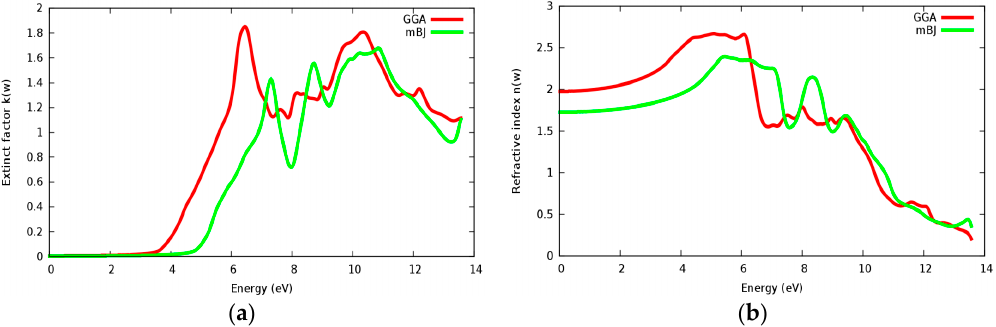
Figure 16. ( a ) Extinct factor k ( ω ); ( b ) Refractive index n ( ω ) for SrZrO 3 compound using both PBE-GGA and mBJ-GGA methods.